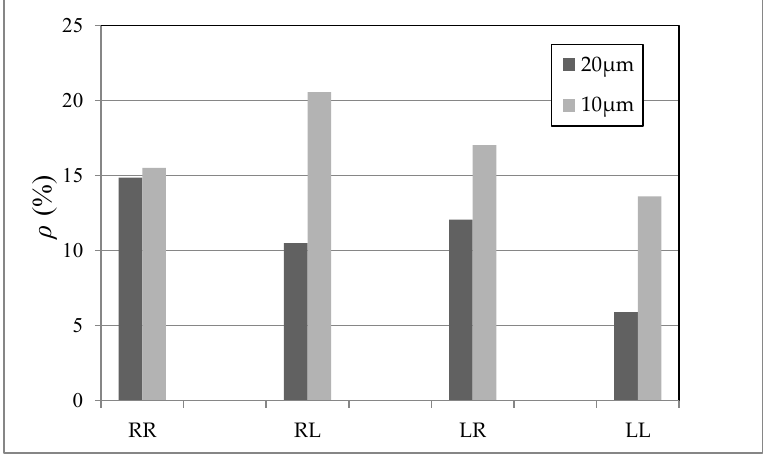
Figure 6. Effect of polysilicon morphology (only) on the scattering of the device response, measured through the ratio ρ between the standard deviations of numerical and experimental data at varying test